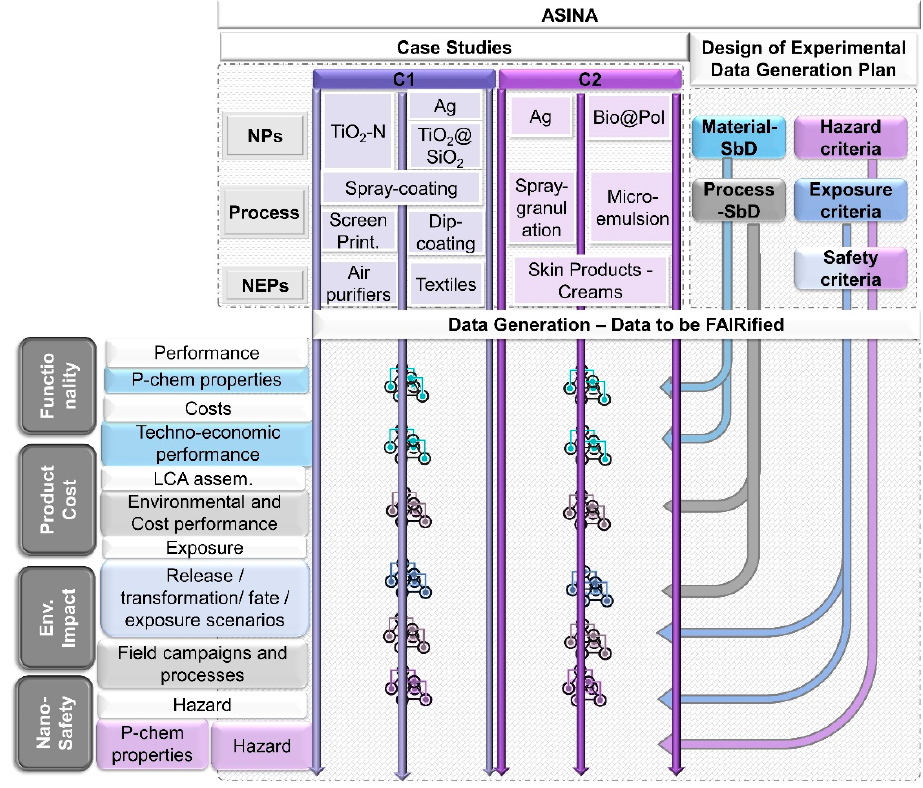
Figure 2. Mapping of case studies including the nanomaterials, processes and products in ASINA. C1 (Category 1) of anti-microbial coating in clean technology and C2 (Category 2) of nano-structured capsules delivering active phases in cosmetics. The design of experimental data generation represents a plan which will allow the objectives of the project to be met. Based on the design, new data across the life cycle production chain will be produced capturing a variety of dimensions around nano-production. This structure allows us to identify categories of future data to be generated and clustered into pillars. The mapping constitutes the first step towards the FAIRification workflow development.